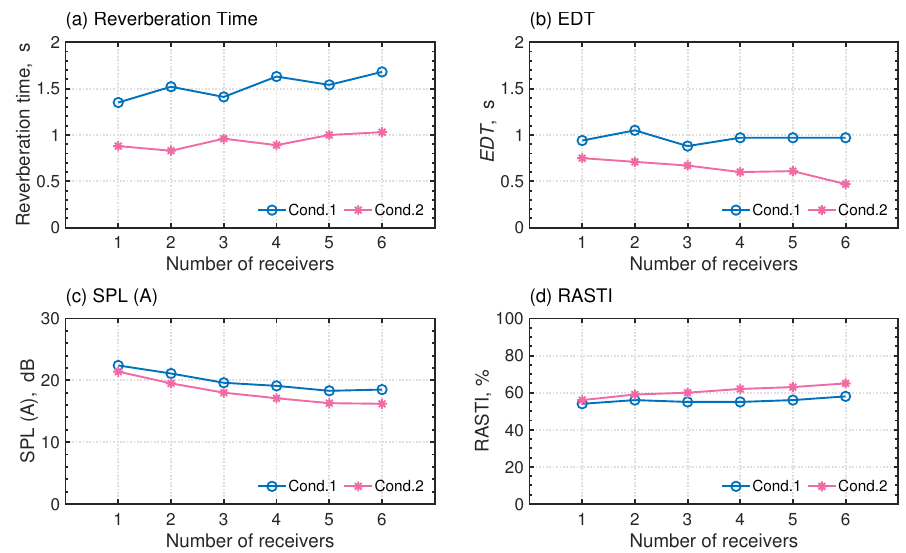
Figure 13. Acoustic parameter: ( a ) reverberation time; ( b ) EDT; ( c ) SPL (A); and ( d ) RASTI. Figure 14 presents a comparison of frequency characteristics of spatially averaged reverberation time and EDT with the Eyring–Knudsen formula. The error bars in numerical results show their standard deviations. The Eyring–Knudsen formula values and T30 values differ except for Cond. 1 at 125 Hz, indicating low diffusivity of sound fields. In Cond. 1, T30 becomes larger with frequencies above 500 Hz, whereas the average absorption coefficient decreases with frequency. The frequency characteristic of Cond. 2’s T30 shows the same tendency as the average absorption coefficient because of cancellation of the flutter echo with the additional absorber. Moreover, EDT values agree with the Eyring–Knudsen formula, which is better than T30 except for Cond. 1 at 125 Hz. The result indicates that the wave-based room-acoustics solver accurately models frequency-dependent absorption characteristics of boundary surfaces.